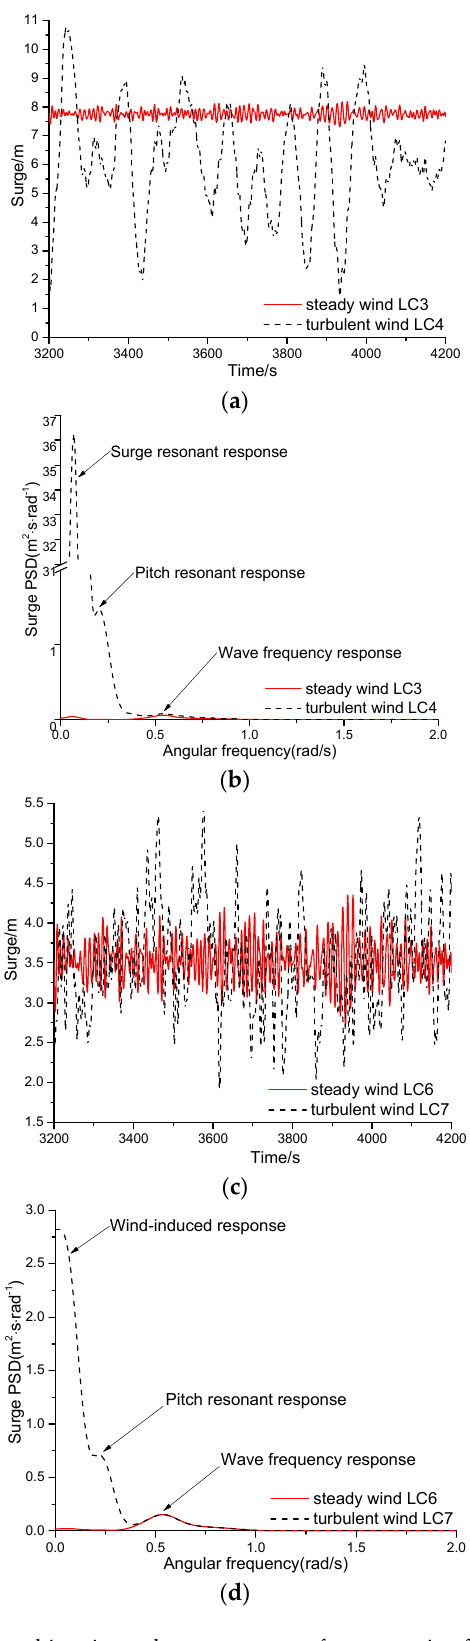
Figure 11. Comparison of time histories and power spectra of surge motion for the steady and turbulent wind cases. ( a ) Time histories of surge motion; ( b ) power spectra of surge motion; ( c ) time histories of surge motion; ( d ) power spectra of surge motion.